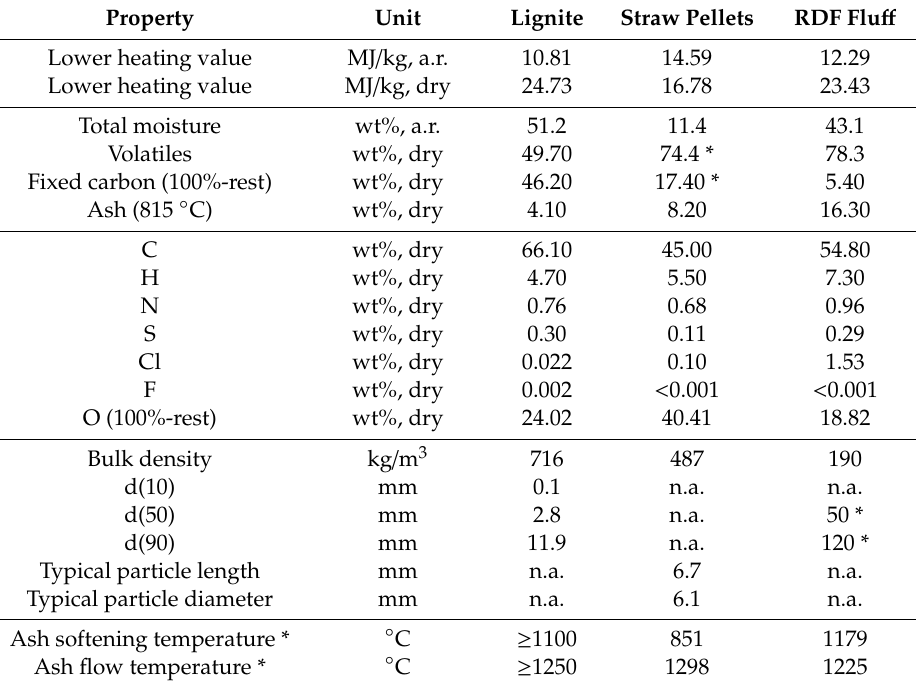
Table 4. Fuel properties (a.r. = as received, n.a. = not analyzed). Property